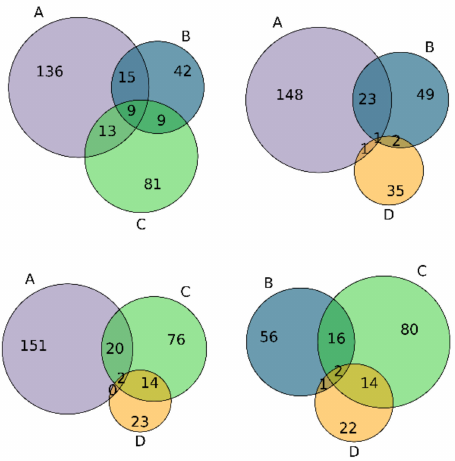
Figure 6. Venn diagrams representing the sca ff olds common to the four IC 50